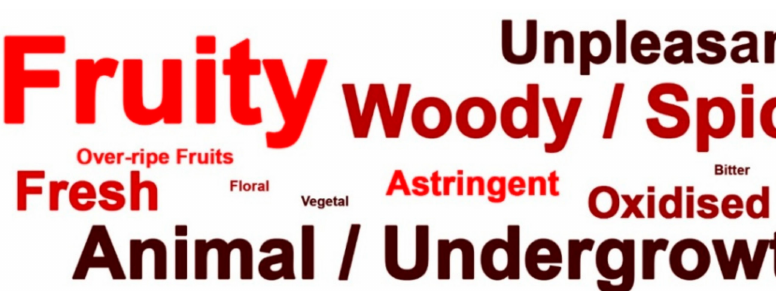
Figure 2. Word cloud of the descriptors elicited by the white wines considered to be organic (SB2016, VB2015, CC2013).